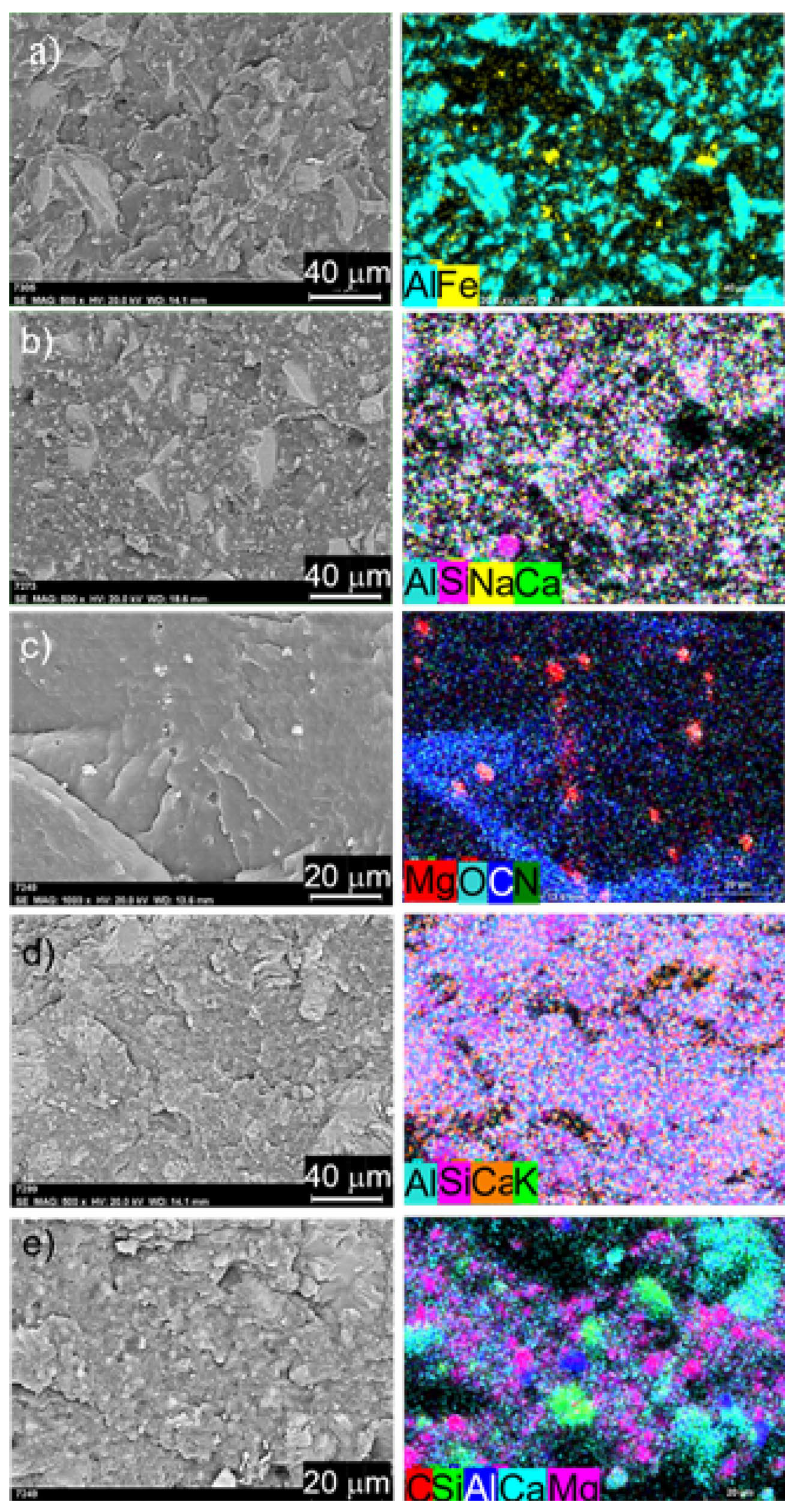
Figure 3. SEM images and the elemental mapping of composites containing 70 wt% of different types of filler composites in PA6 matrix: ( a ) Al 2 O 3 , ( b ) Fritt1, ( c ) MgO, ( d ) natural zeolite, and ( e ) PA/MgO-70/Zeo80-50/50 hybrid